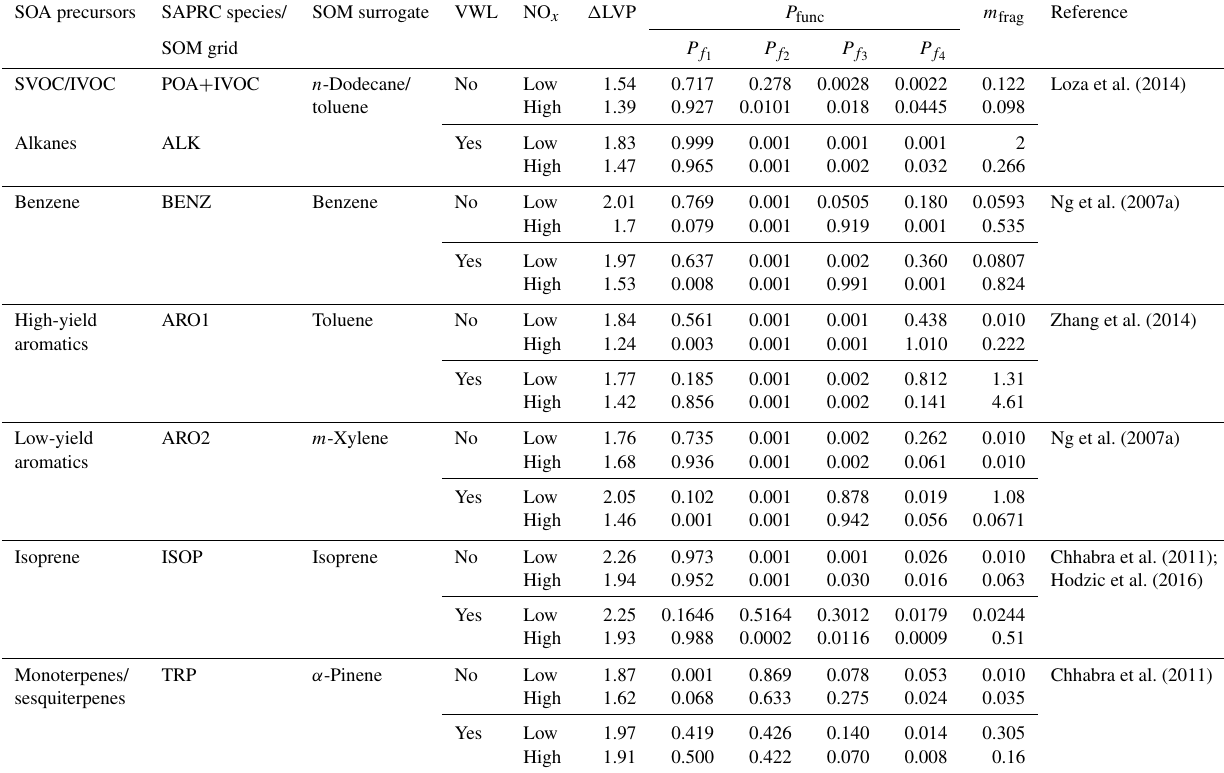
Table 1. SOA precursors and SOM parameters used in this work. VWL: vapor wall loss corrected; (cid:49) LVP: change in vapor pressure linked to addition of one oxygen atom; P func : molar yields of species that add one to four oxygens per reaction ( P f influencing the probability of